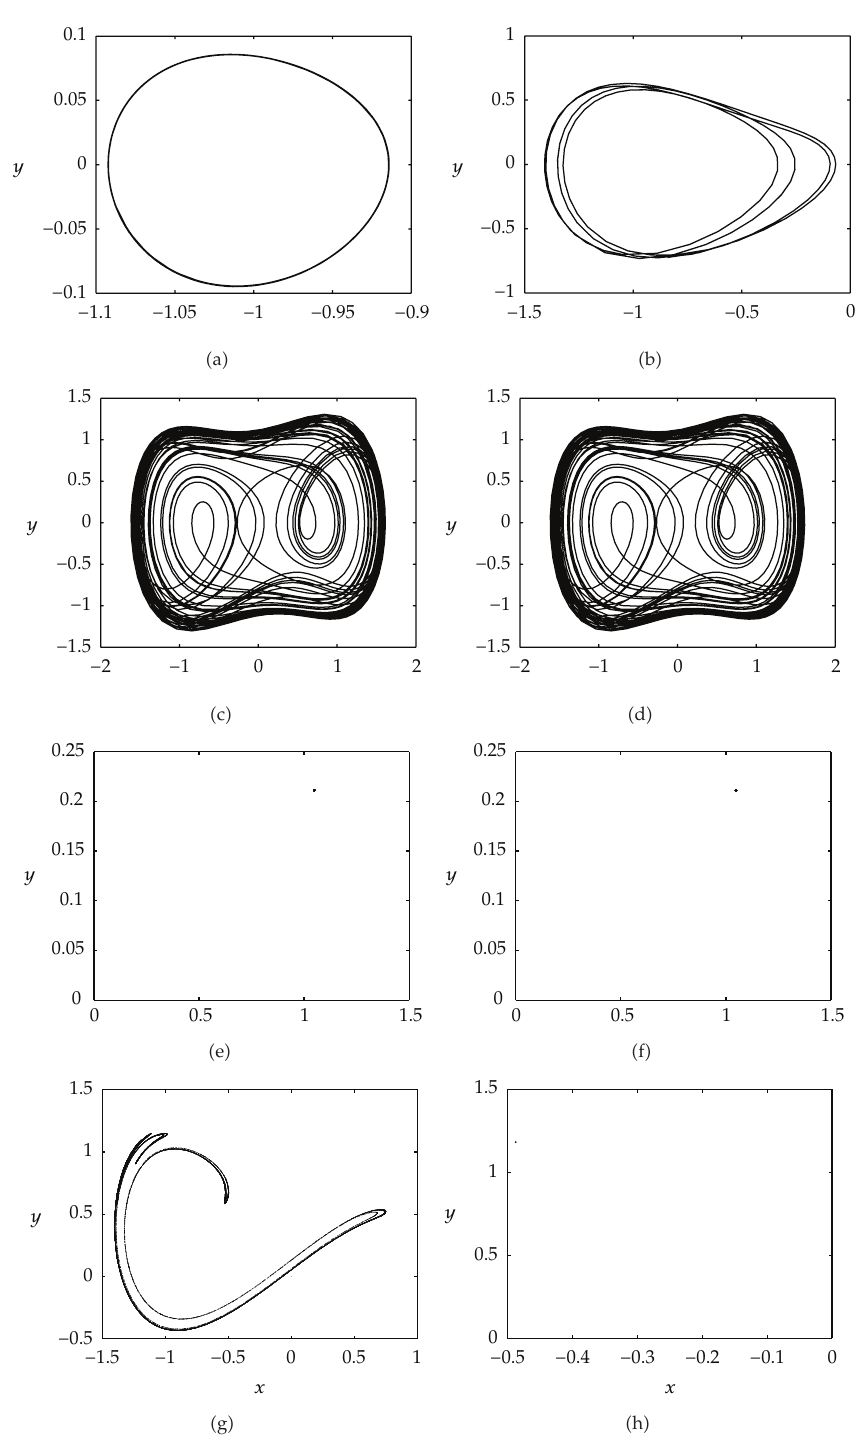
Figure 4: (cid:6) a, b, c, and d (cid:7) Phase portraits of the system (cid:6) 1.3 (cid:7) ; (cid:6) e, f, g, and h (cid:7) Pioncar´e maps of the system (cid:6) 1.3 (cid:7)